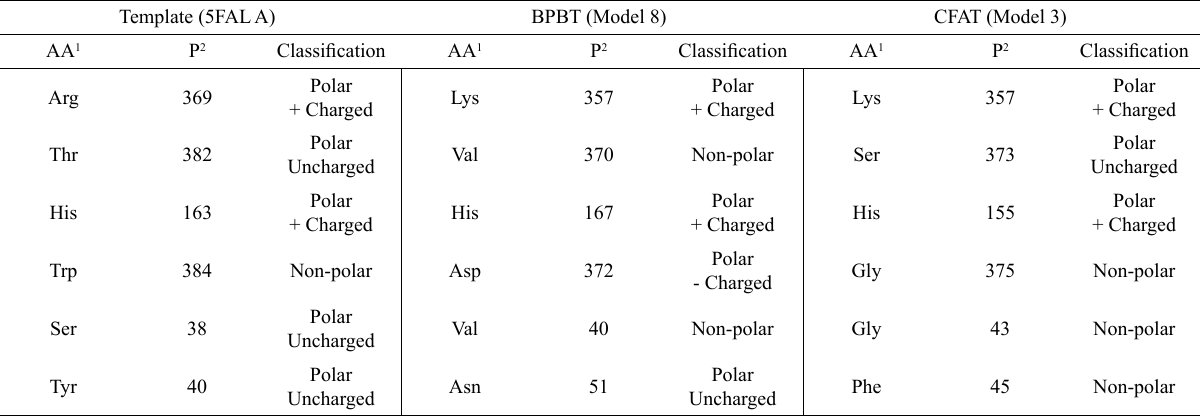
Table 2 – Amino acid residues described as important for the protein function in template (PDB ID: 5FAL A) and their correspondent positions in the modelled PhBPBT and PhCFAT